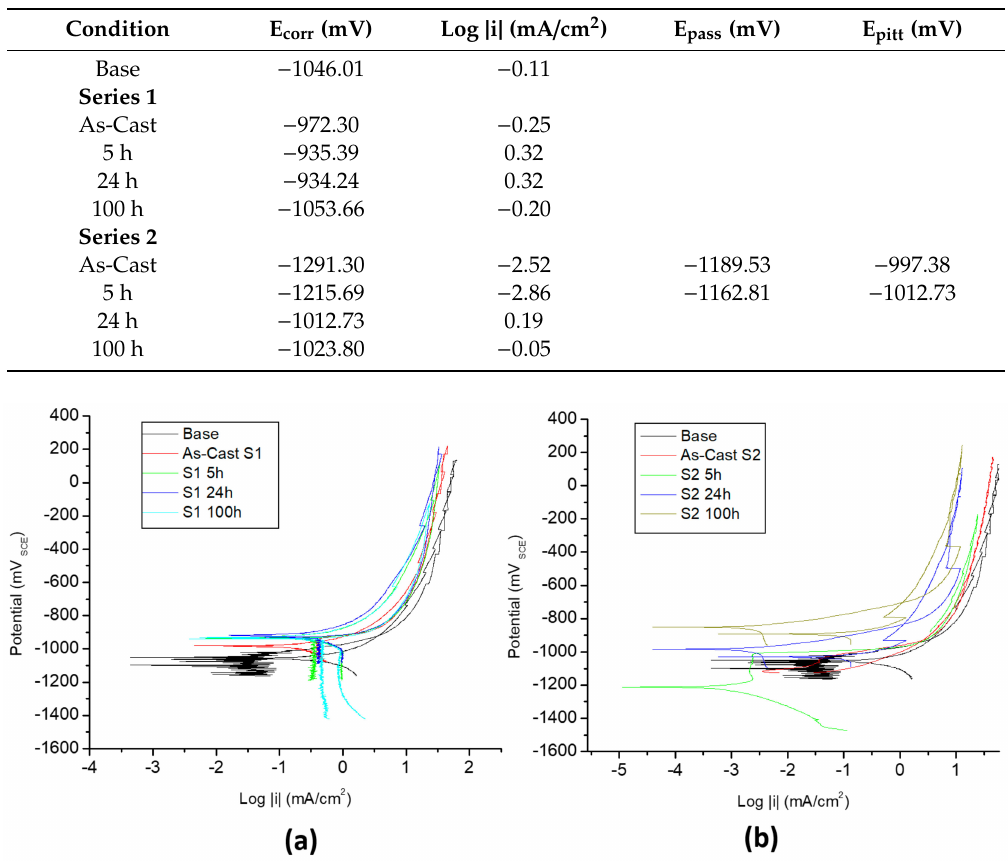
Table 6. The electrochemical values obtained from the polarization curves of the AlMgZn alloys.